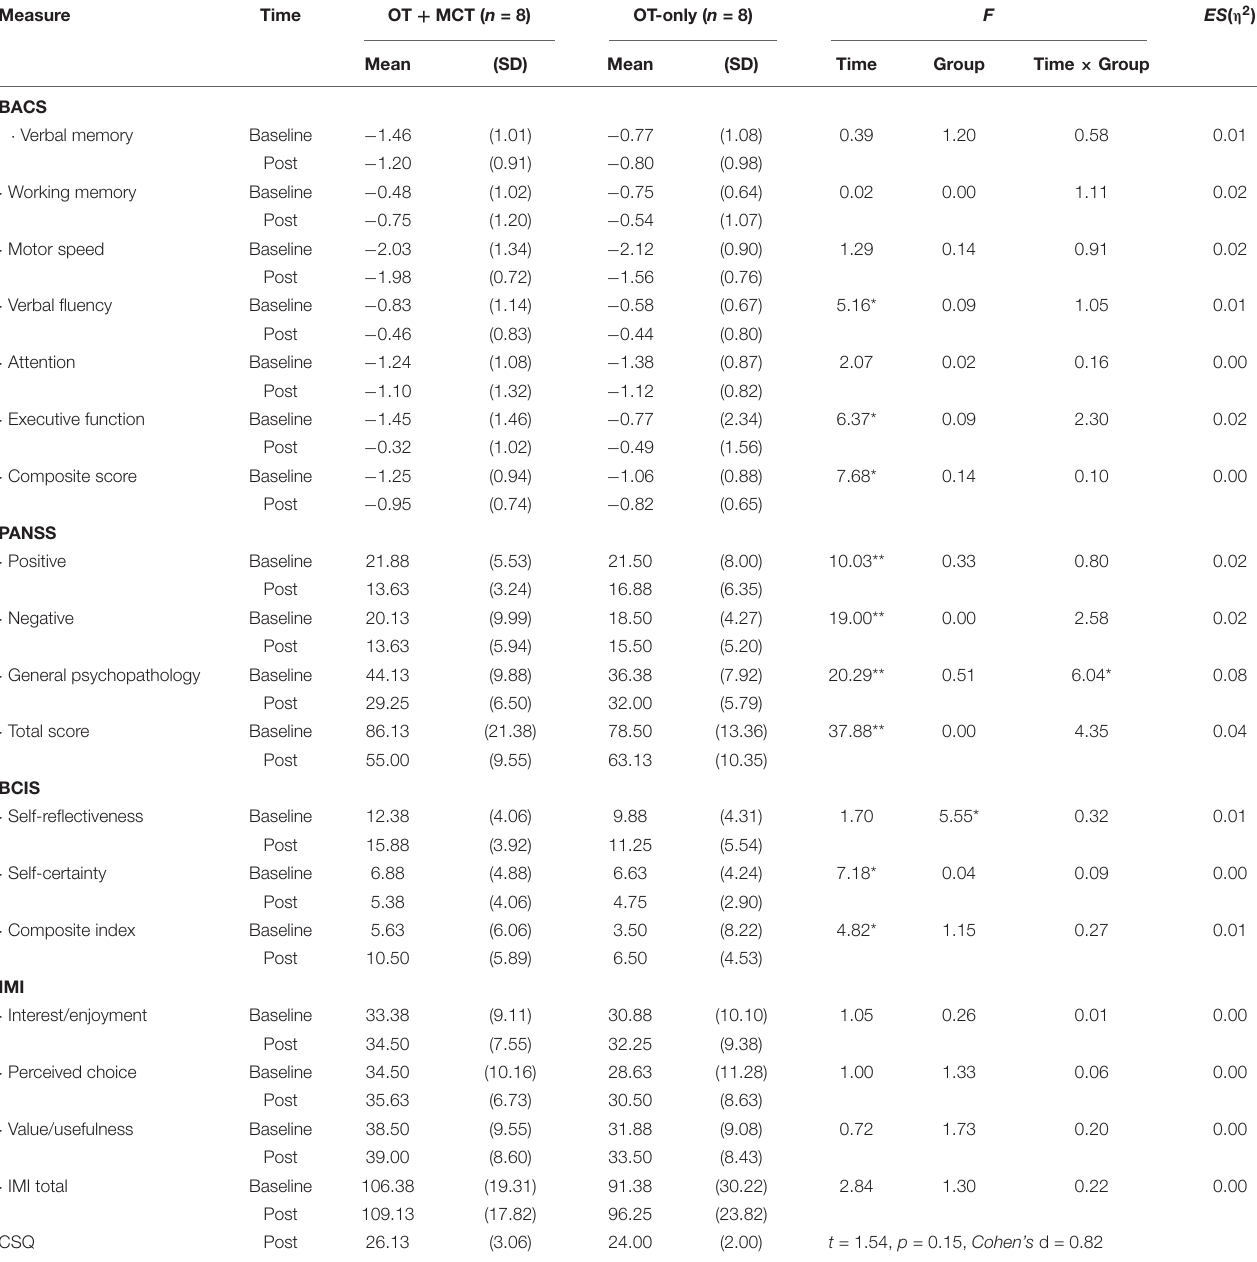
TABLE 2 | Assessment score analysis by two-way repeated-measures